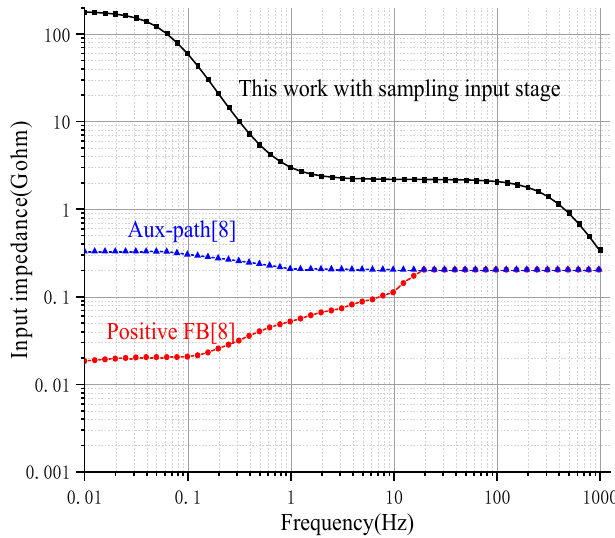
Figure 10. The input impedance of the ECG amplifier using different impedance-boost techniques.